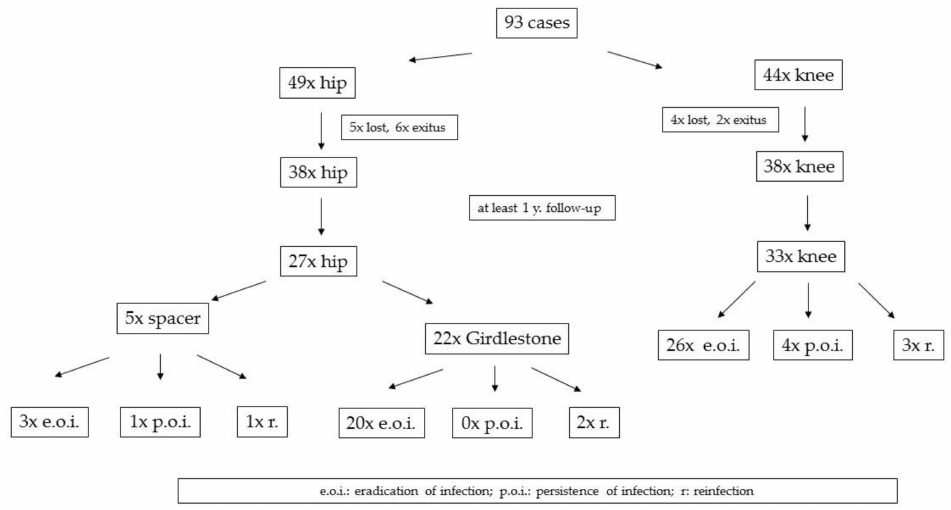
Figure 3. Infection